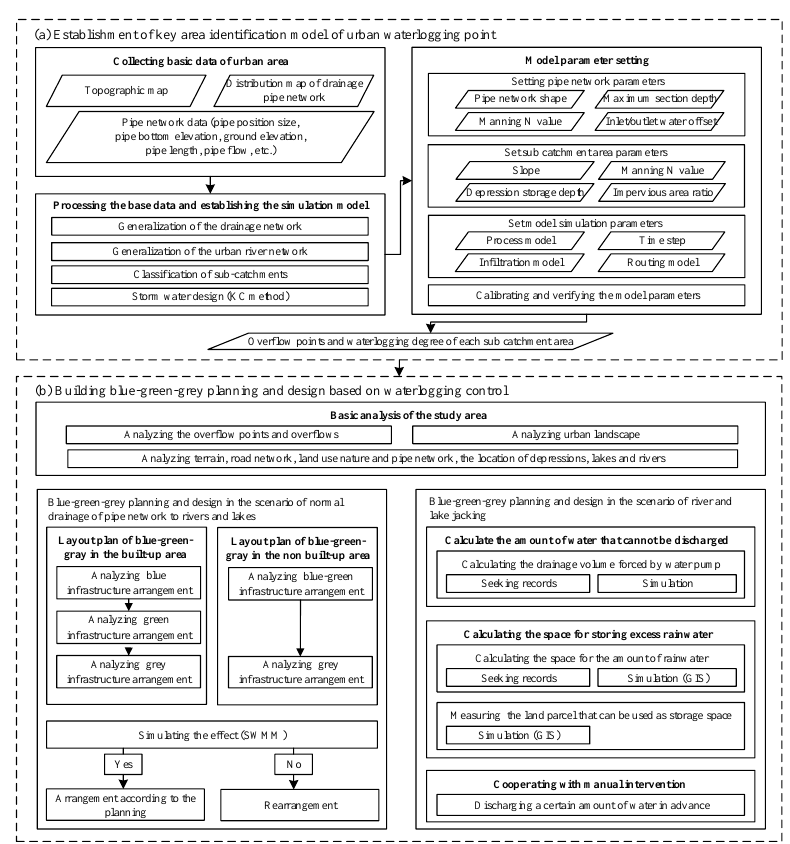
Figure 2. The flow